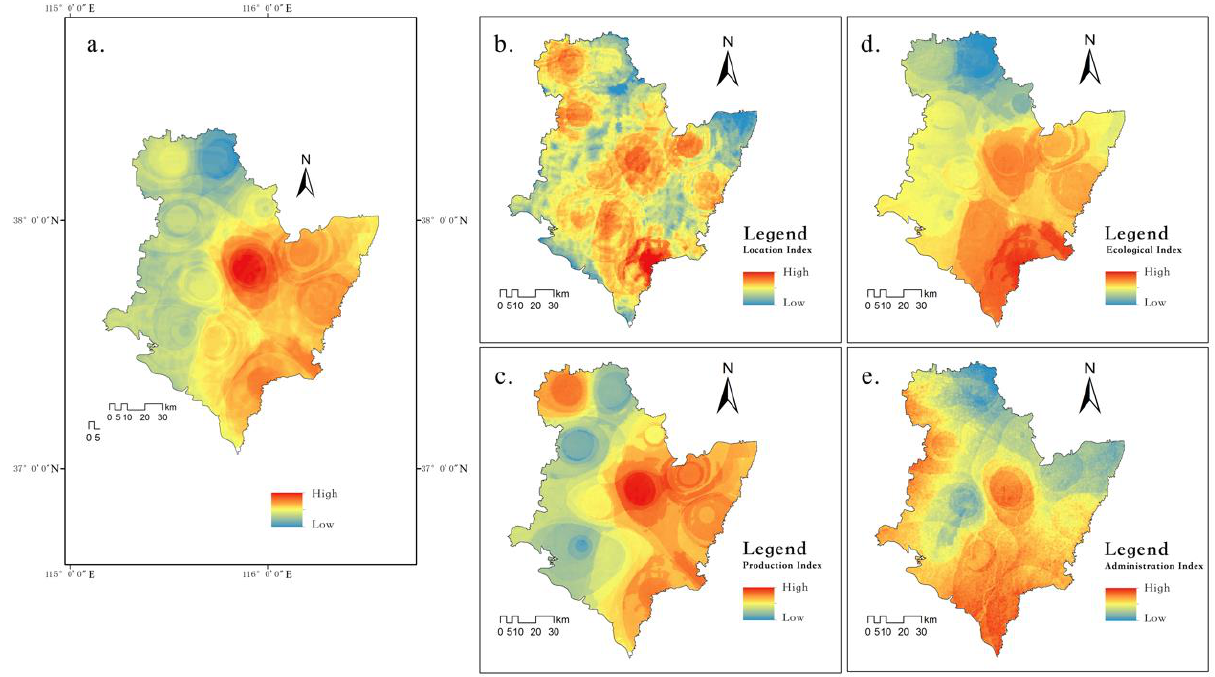
Figure 8. Spatial comparison between the middle layer index suitability distribution map and the human settlements suitability distribution map: ( a ) the human settlements suitability distribution map; ( b ) location index suitability distribution map; ( c ) production index suitability distribution map; ( d ) ecological index suitability distribution map; ( e ) administration index suitability distribution map.